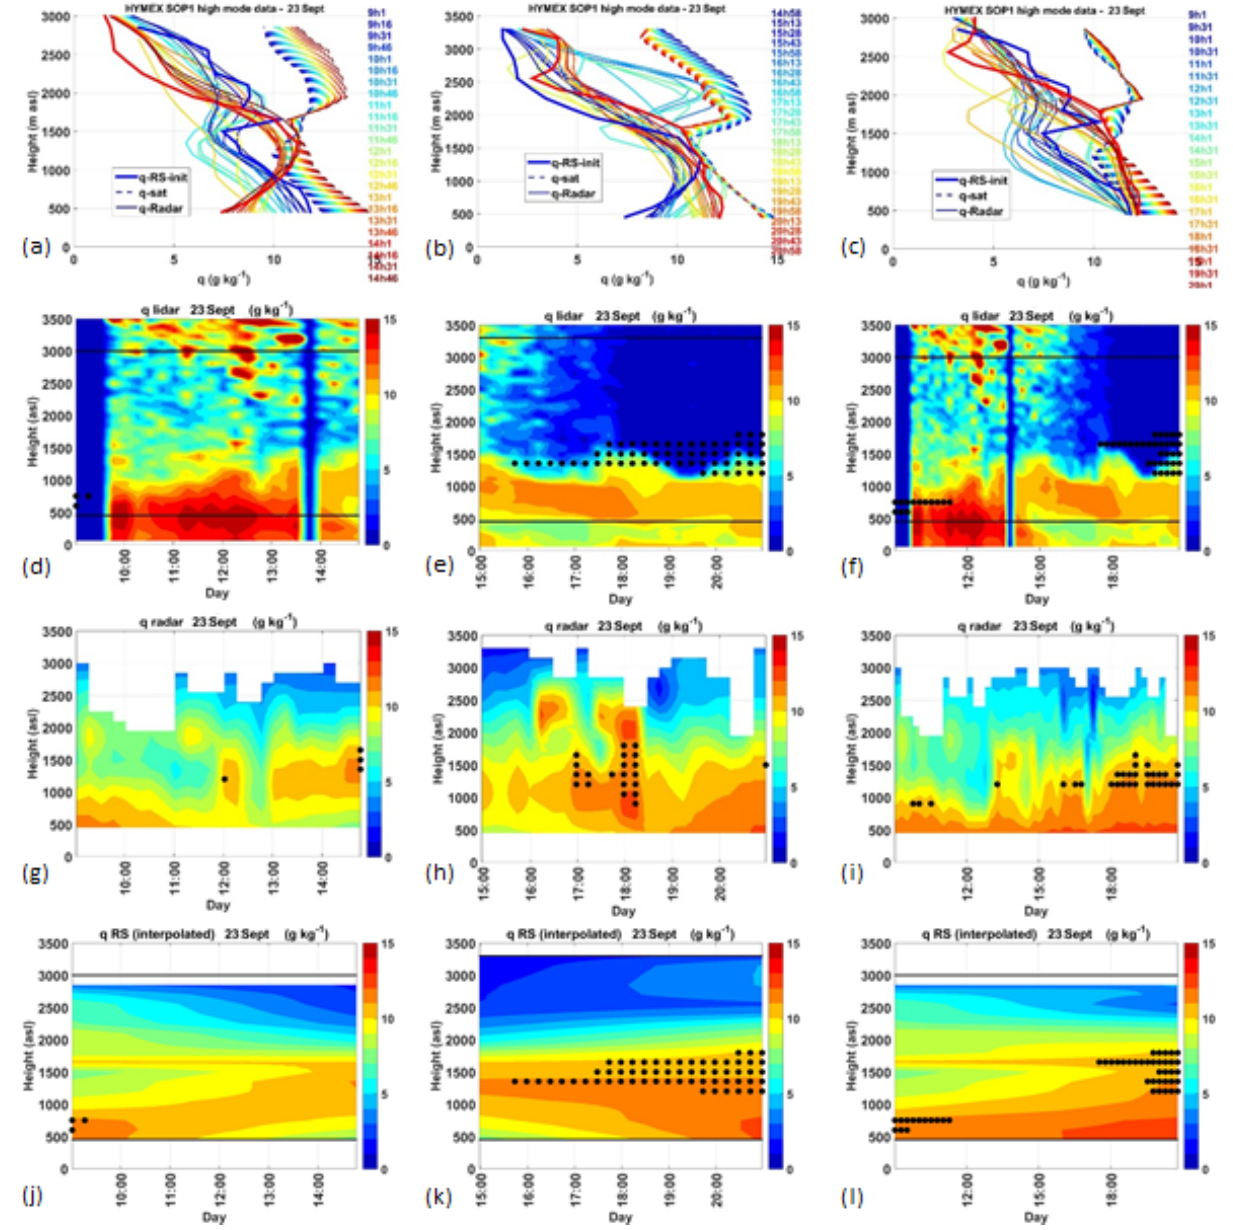
Figure 8. Radar-based humidity profiles and humidity height–time cross sections for the 23 September HyMeX case study: from RS1 (09:02UTC, blue solid line in a ) to RS2 (14:59UTC, red solid line in a ), from RS2 (blue, b ) to RS3 (20:58UTC, red solid line in b ) and from RS1 (blue, c ) to RS3 (red, c ). First row is for the radar profiles (same details as in Fig. 6), second for the height–time humidity of the lidar, third for the radar and fourth for the interpolated RS. The dots in the last three rows demarcate the saturated values as in Fig.